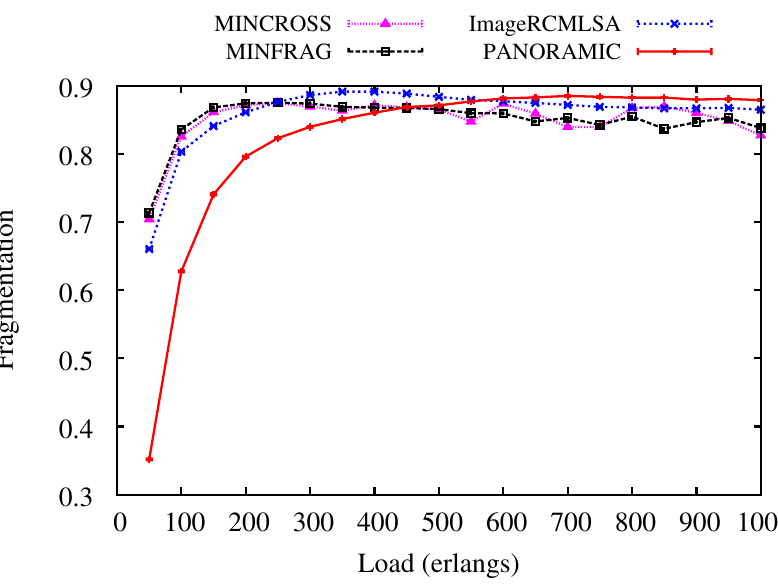
Figure 9. Fragmentation Ratio for NSF